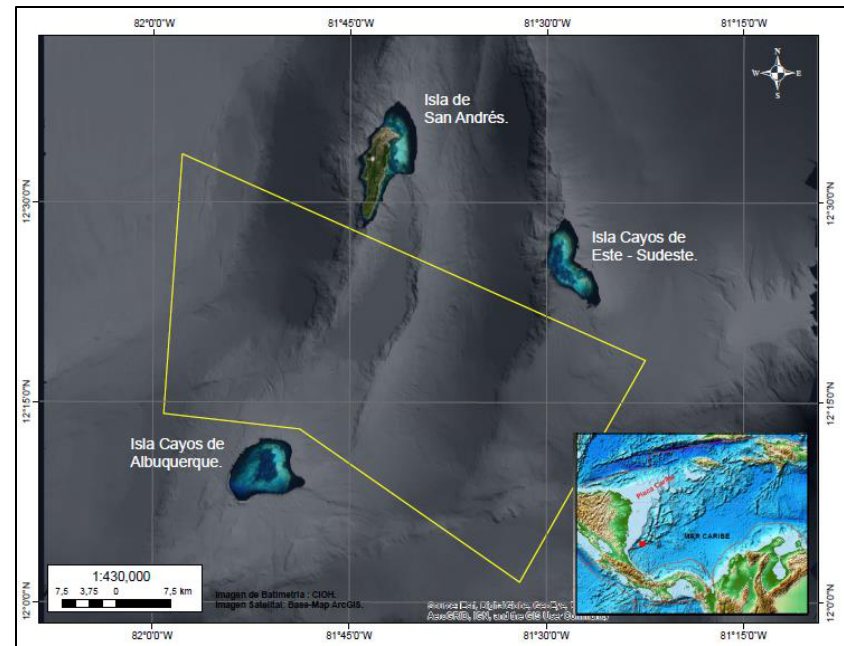
Figure 1. Polygon of acquisition in study area.